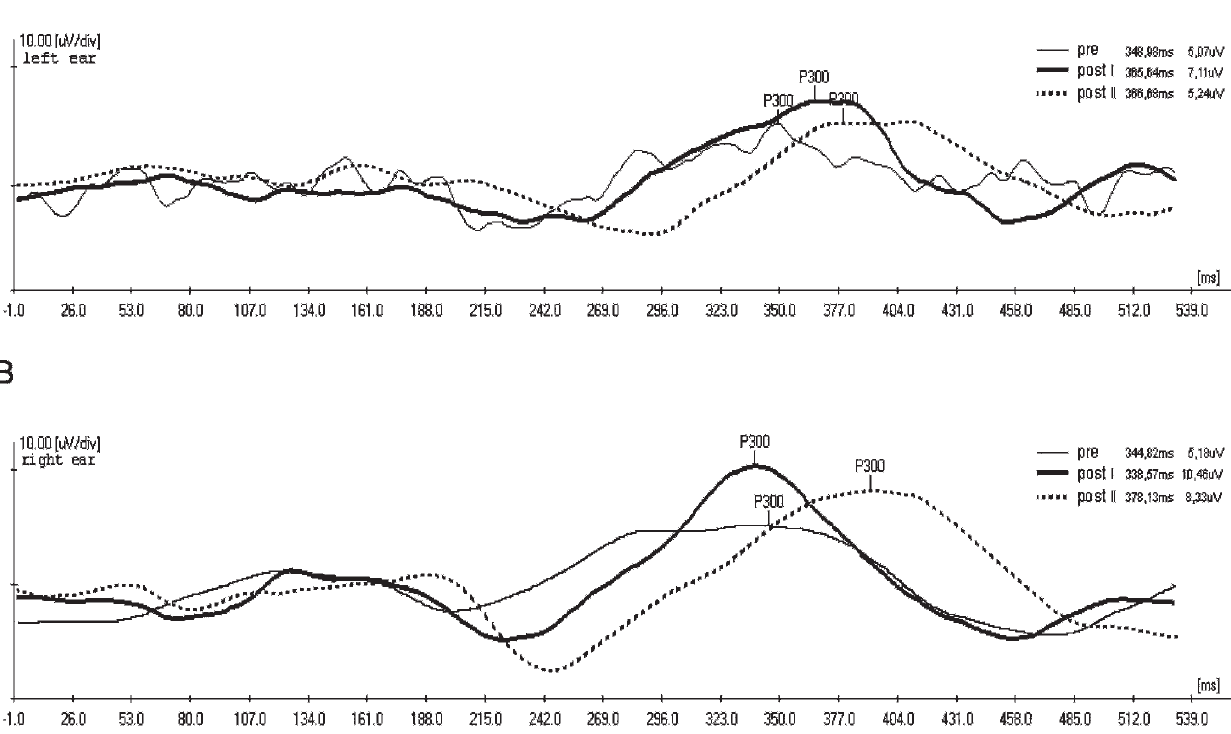
Figure 1 – Results of the P300 Long-Latency Evoked Auditory, test in both ears, pre- and post-auditory training. A: LEFT EAR, PRE- TRAINING: latency 348,98 ms, amplitude 5,07 m V; POST-TRAINING I: latency 365,64 ms, amplitude 7,11 m V; POST-TRAINING II: latency 366,68 ms, amplitude 5,24 m V. B: RIGHT EAR, PRE-TRAINING: latency 344,82, amplitude 5,18; POST-TRAINING I: latency 338,57, amplitude 10,46; POST-TRAINING II: latency 378,13 ms, amplitude 8,33 m